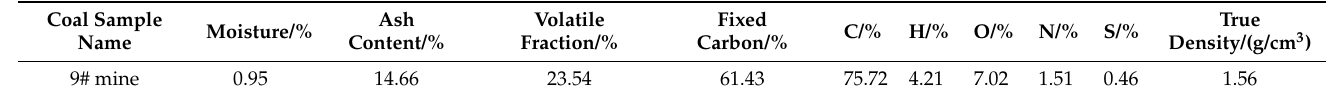
Table 1. Industrial analysis and elemental analysis data of coal samples.